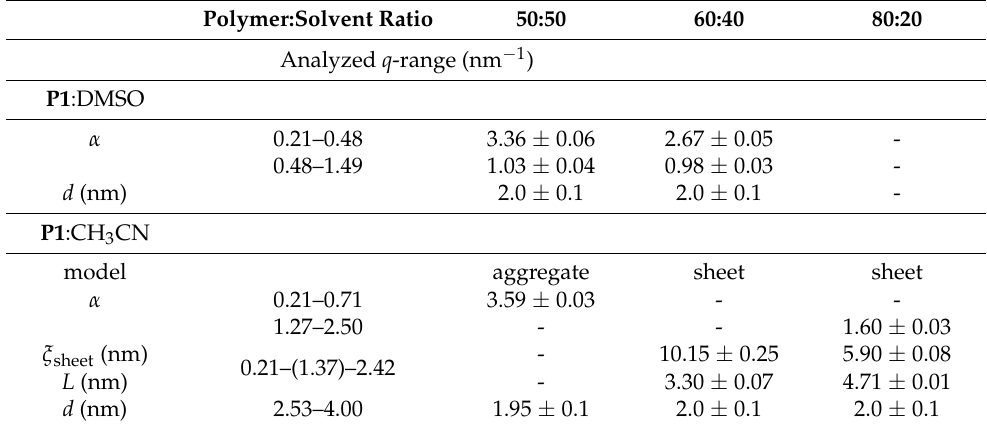
Table 3. Parameters estimated from the fits to the small-angle X-ray scattering (SAXS) data of polymer 1 in DMSO and CH 3 CN: α is the power-law exponent, ξ sheet and L are the size and thickness of the polymer sheets while d is the long period deduced from the observed interference